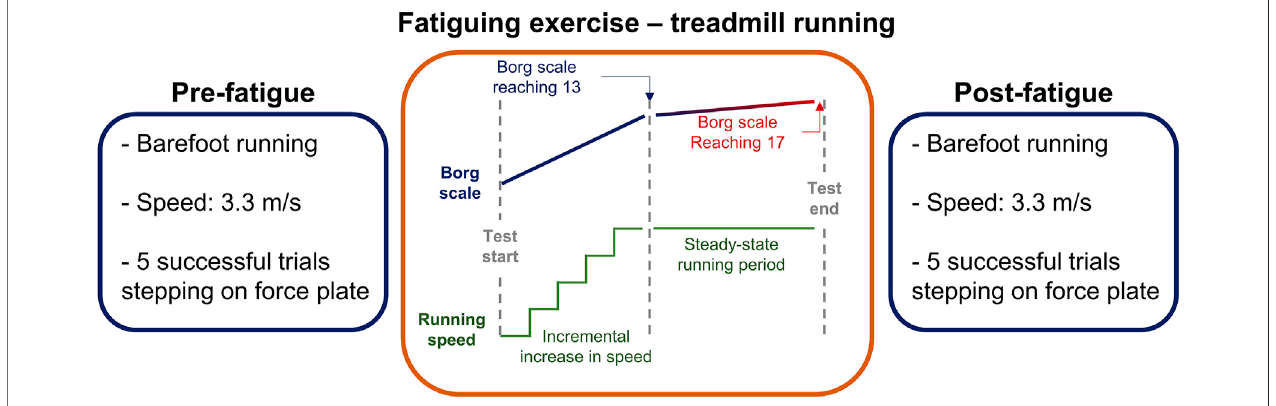
FIGURE 1 | Illustration of the experimental protocol involving barefoot running before (pre-fatigue) and after (post-fatigue) the application of a fatigue